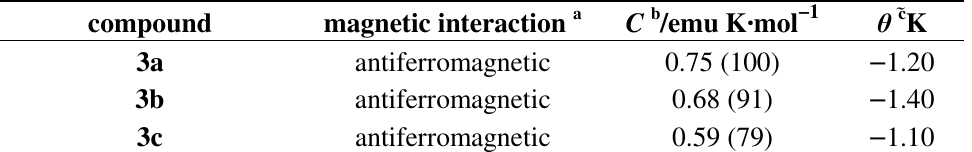
Table 2. Magnetic data of TCNQ derivatives 3a – 3c